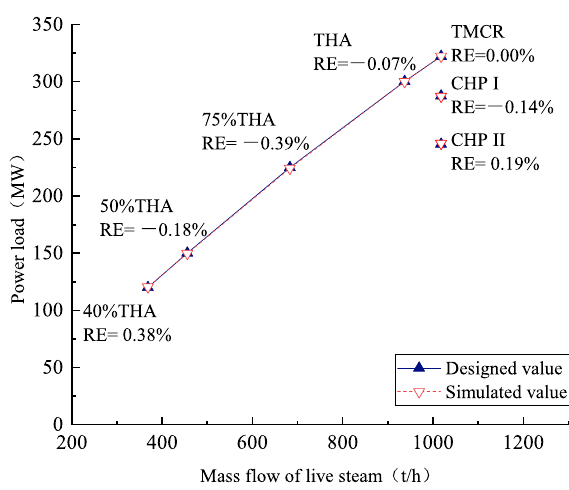
Figure 4. Comparison between simulation results and design